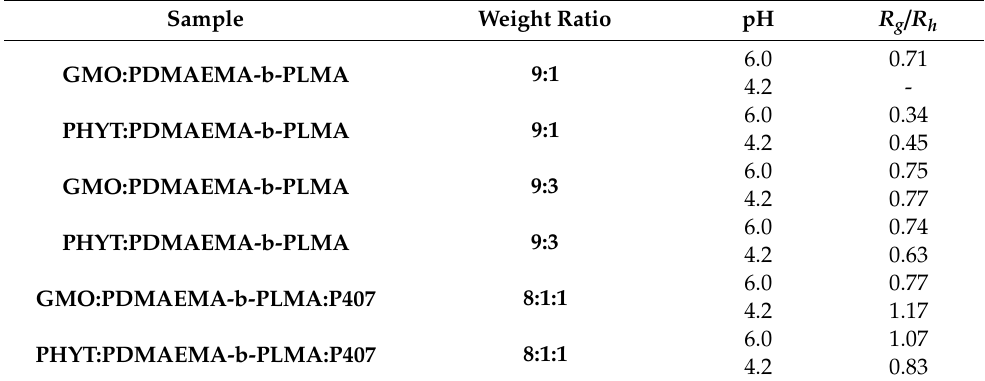
Table 4. The R g / R h ratio of the prepared nanosystems depending on the pH of the dilution environment.